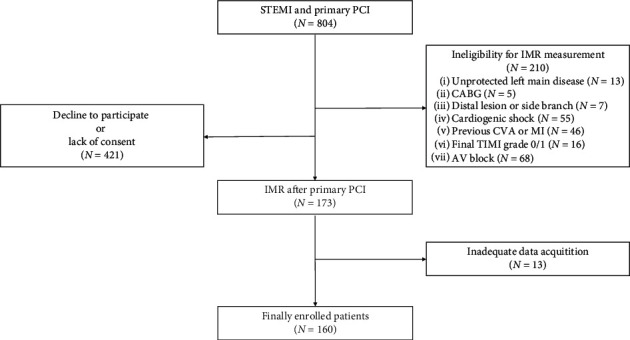
Study flowchart.